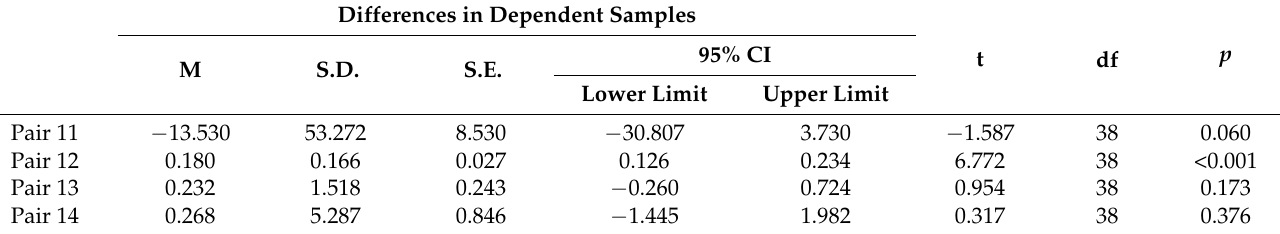
Table 9. Test for dependent samples.